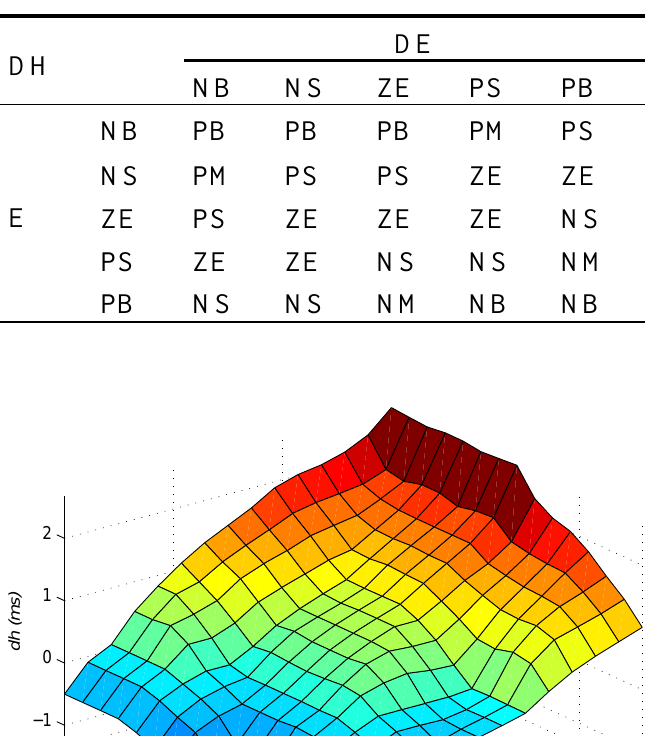
Figure 4. Input and output membership functions. Table 1. Linguistic rules.